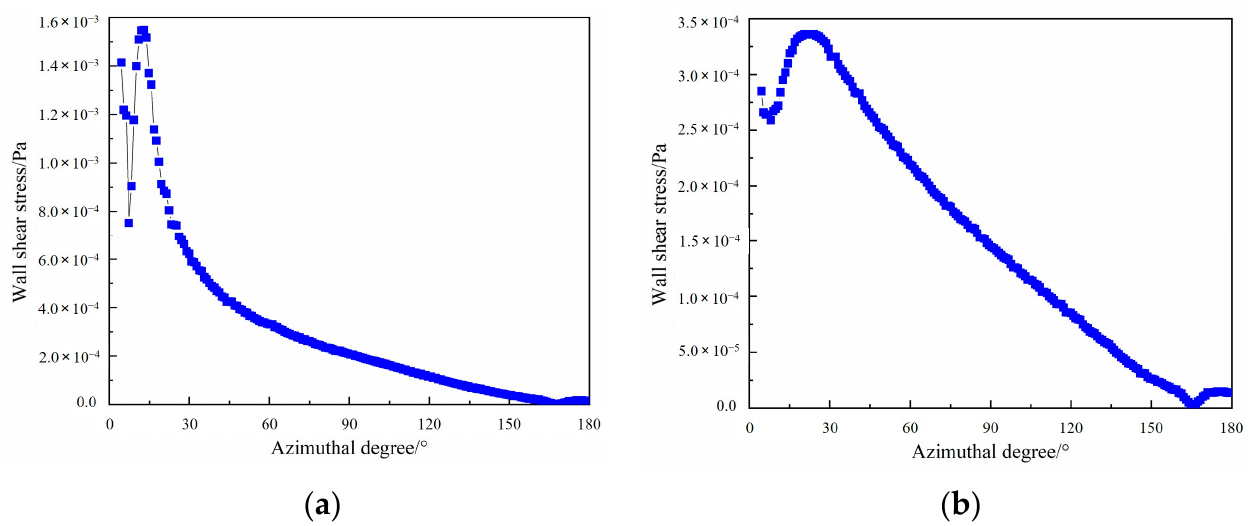
( b ) Figure 8. Iron flow fields of No. 7 case: ( a ) in the xz cross section through taphole and ( b ) in the xy cross section with 1.5 m height from the hearth bottom. The shear-stress distributions on the semi-circumferential curves (at the height of 1.5 m) of the sidewall between the original the No. 1 BF case and the No. 7 case are shown in Figure 9. In the No. 7 case, the average wall shear stress is largely reduced compared with that of the original No. 1 BF case, with the peak shear stress dropping from 1.58 × 10 − 3 Pa to 3.36 × 10 − 4 Pa. Figure 10 shows the shear-stress distribution on the inner-sidewall of the hearth in the No. 7 case. It can be seen that the shear-stress distribution is still symmetrical about the taphole. The highest shear-stress area (except for the mud ladle) is located on both sides of the taphole, with an azimuthal angle of about 25°. The shear stress below the taphole becomes obviously smaller compared with the value shown in the original No. 1 BF case (see Figure 4a), which can be explained by the weakening of the iron circulation